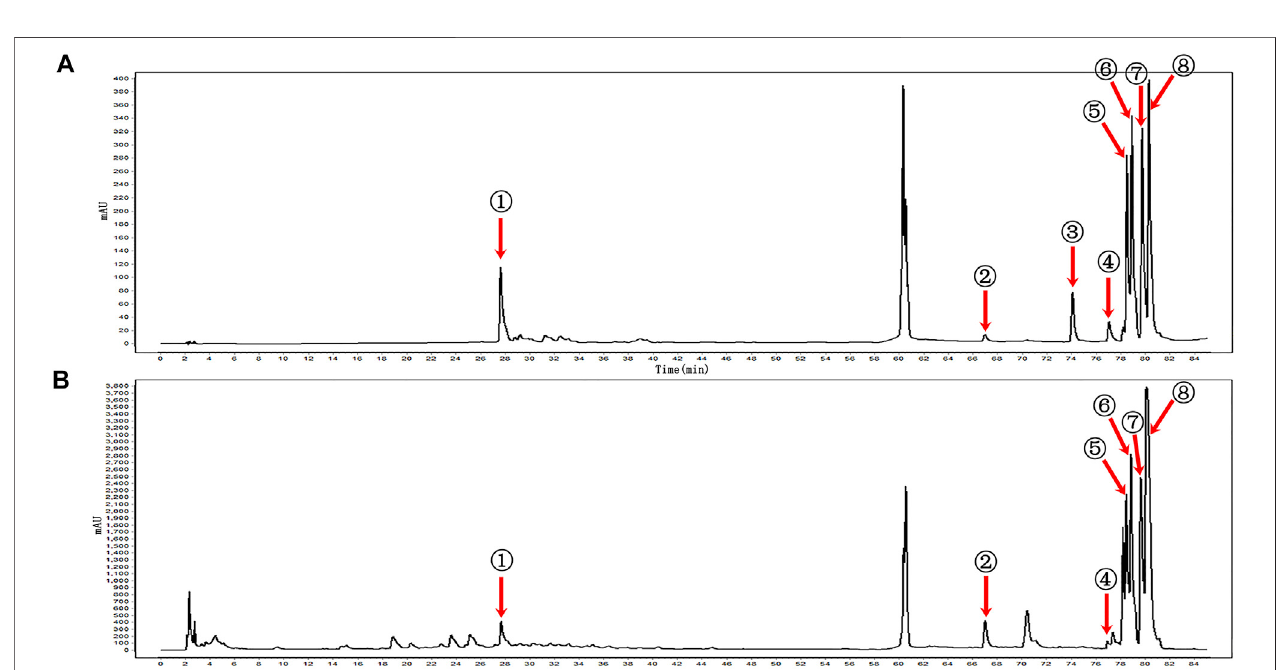
FIGURE 1 | HPLC pro fi les of the main components of KBN. (A) Mixed reference; (B) KBN; ① Gentiopicrin; ② Eugenol; ③ Carvesol; ④ Indirubin; ⑤ Epiberberine; ⑥ Coptisine; ⑦ Palmatine; ⑧ Berberine.